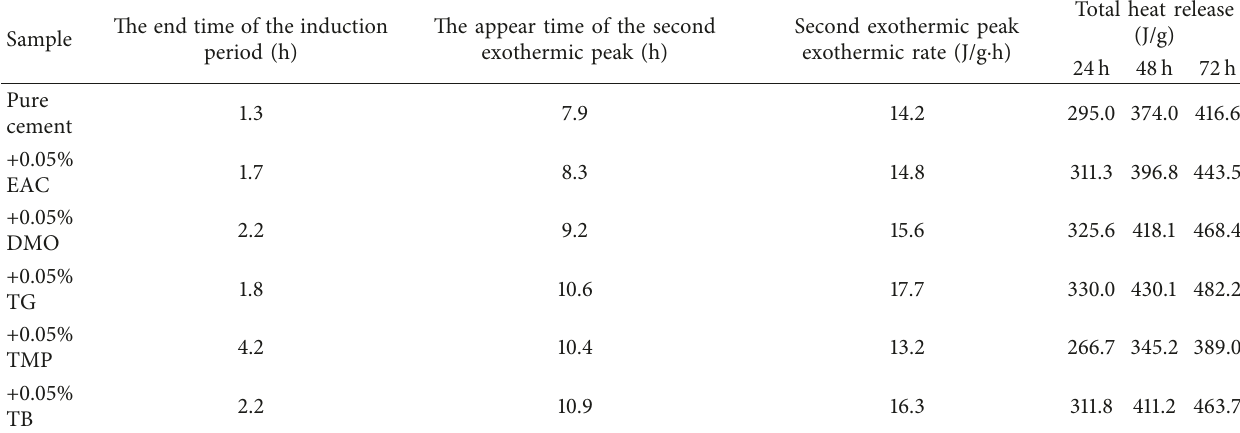
Table 4: Characteristic parameters of cement